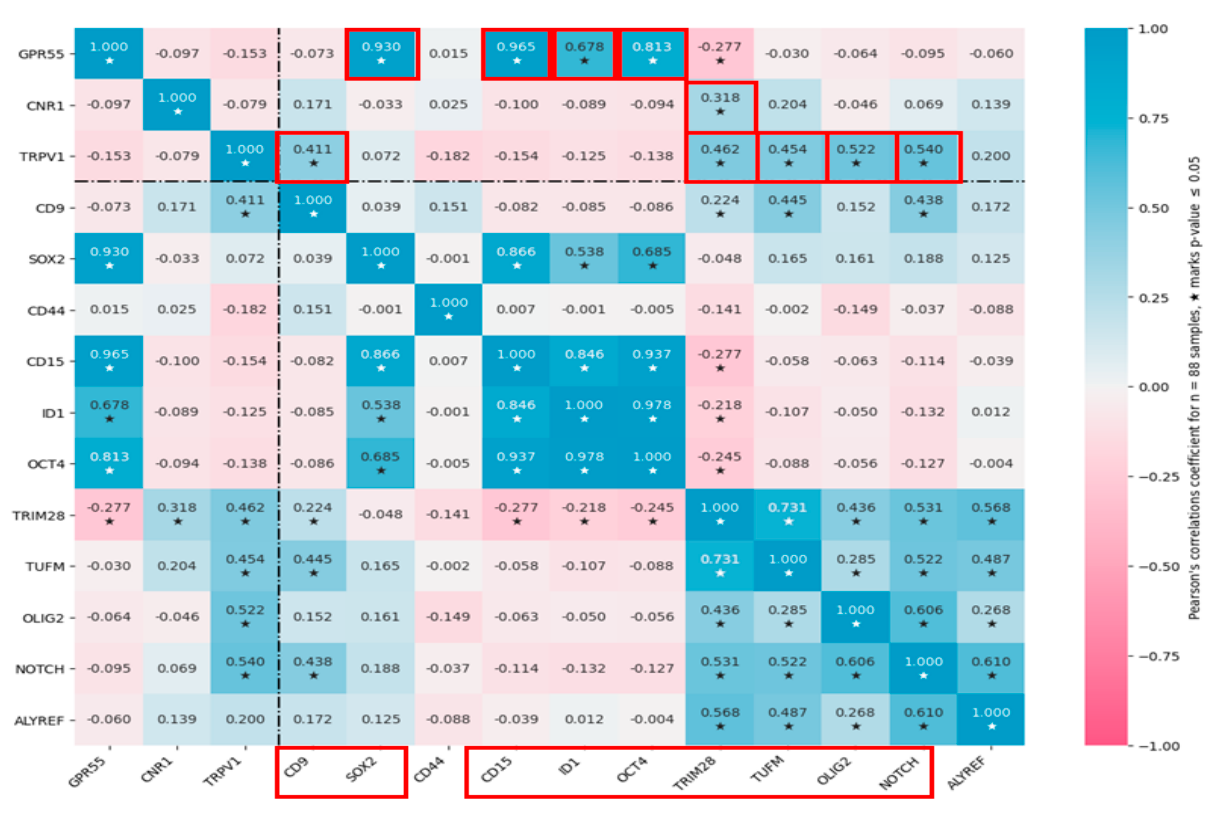
Figure 4. Correlations between the expressions of cannabinoid receptors and GSC markers in glioblastoma. Stemness genes are framed in red below. Correlations with cannabinoid receptors are framed in red above. GPR55 significantly correlated with the GSC markers SOX2 , CD15, ID1 , and OCT4. TRPV1 significantly correlated with NOTCH ; OLIG2 ; and the putative markers CD9, TRIM28 , and TUFM (the latter three of which are potential candidates to be classified as established stem cell markers [32–34]). CNR1 only correlated (poorly) with TRIM28 . * p < 0.05.